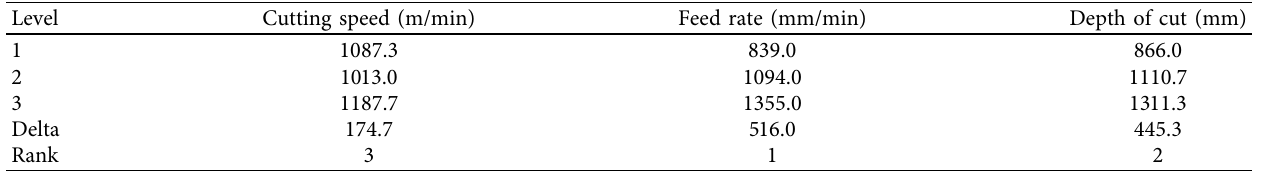
Table 7: Response table for S/N ratio for each cutting condition of Inconel 718 alloy. Level